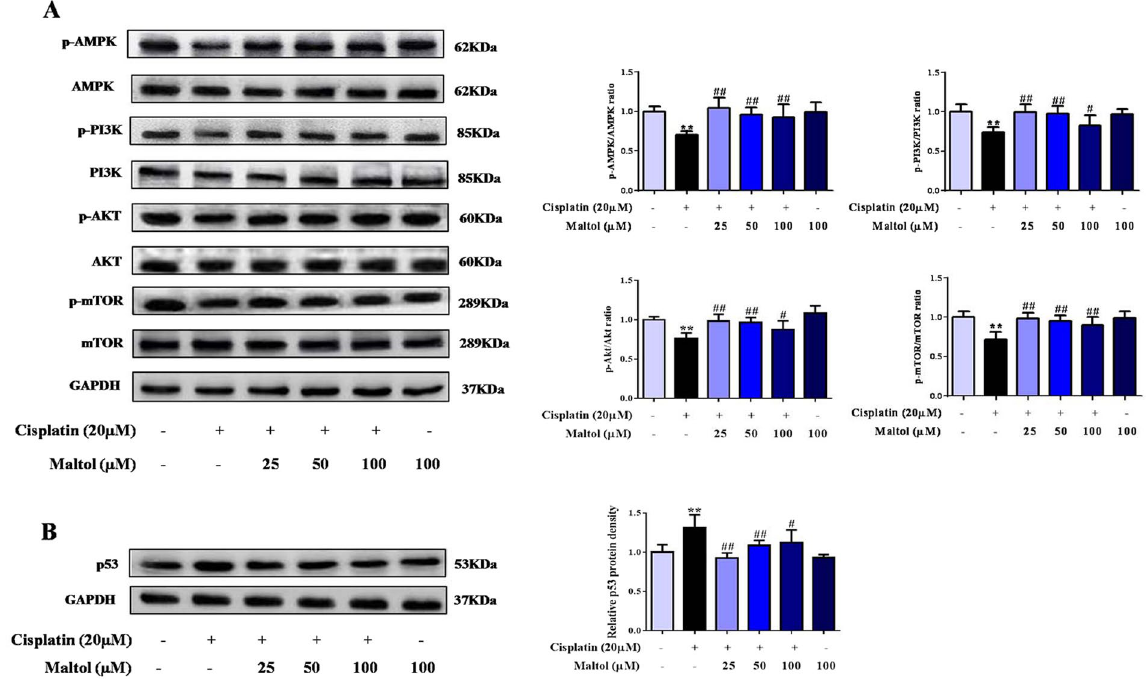
Figure 6. Effects of maltol on cisplatin-induced protein expression of PI3K/AKT signaling pathway. ( A ) Effects of maltol on the protein expression levels of AMPK/PI3K/Akt signaling pathway as well as GAPDH protein was used as a loading control. ( B ) Effects of maltol on the protein expression levels of p53 protein (left panel). Column charts show antibodies relative expression, protein expression was performed by quantification of relative protein expression analysis in HEK293 cells from each group (right panel). Values are expressed as mean ± S.D. n = 8. ** p < 0.01 vs . normal group; # p < 0.05, ## p < 0.01 vs . cisplatin